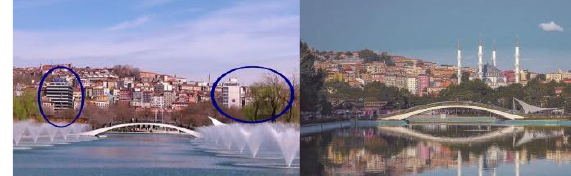
Figure 6: Views of the Hergelen Square from Gençlik Park in 2013 (on the left, the marks indicate the demolished TIKA and Bank of Municipalities Buildings) and in 2017 (on the right, the new mosque has been built).